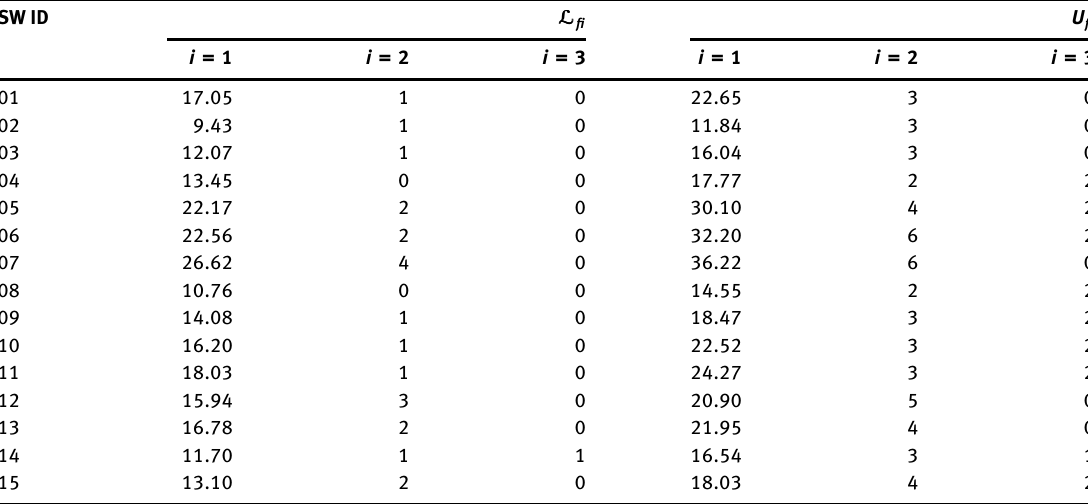
SW ID indicates search word index.